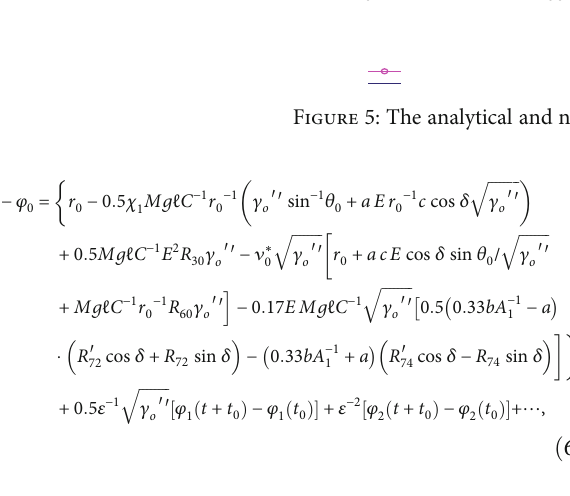
ffiffiffiffiffiffiffiffi ′′ γ o